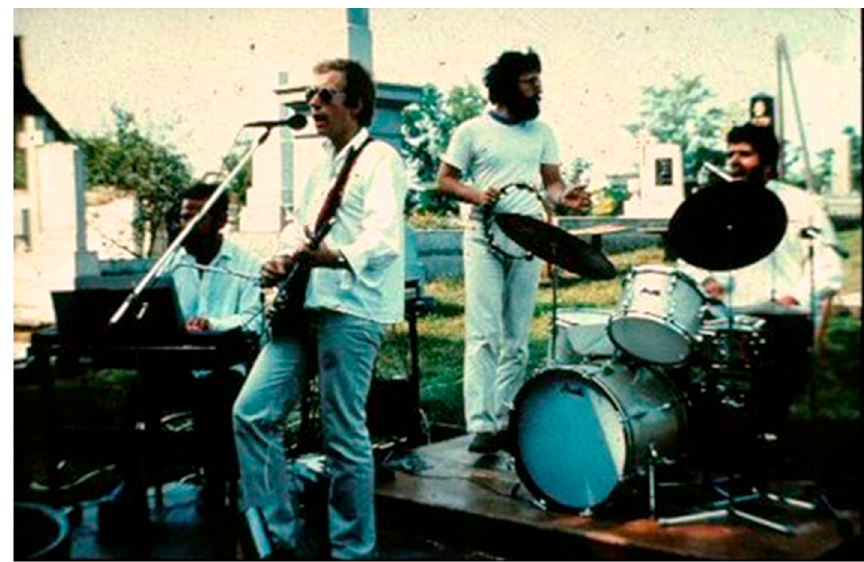
Figure 2. Youth festival in Bokod in 1980. (Source: the author’s personal collection).